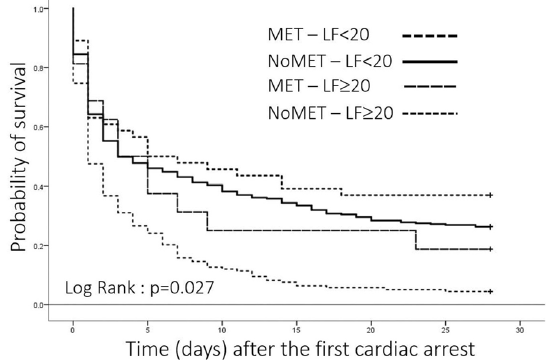
Fig. 1 Survival analysis of the 555 having or not an ongoing treatment by MET at the time of the first CA, groups MET‑LF < 20, MET‑LF >